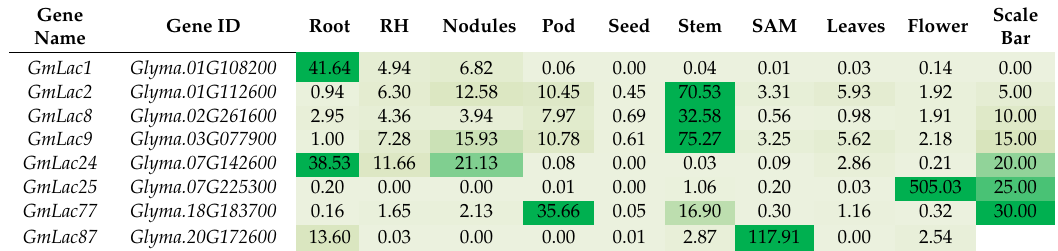
Table 2. Organ- / tissue-specific expression of GmLac